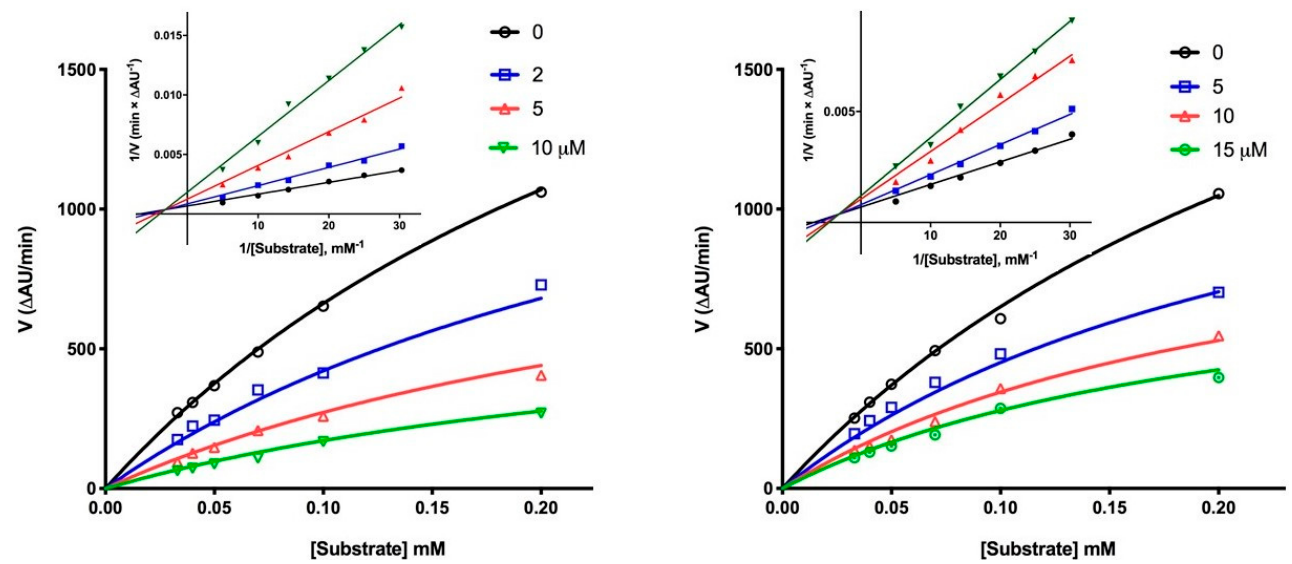
Figure 2. Michaelis-Menten plots for the inhibition of human acetylcholinesterase ( h AChE) by 14 ( left ) and 17a ( right ) at various inhibitor concentrations. The insets display the corresponding Lineweaver-Burk plots.